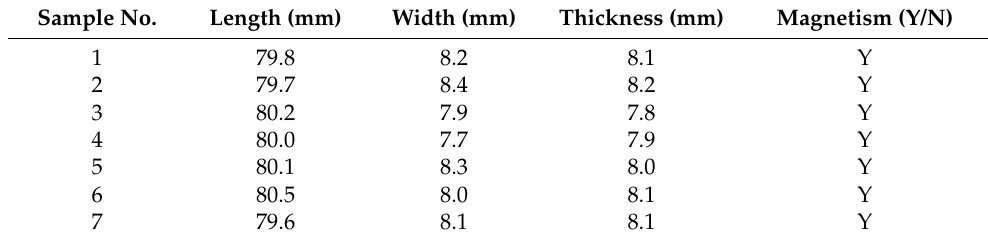
Table 1. Primary dimensions and magnetic properties of the samples. Sample